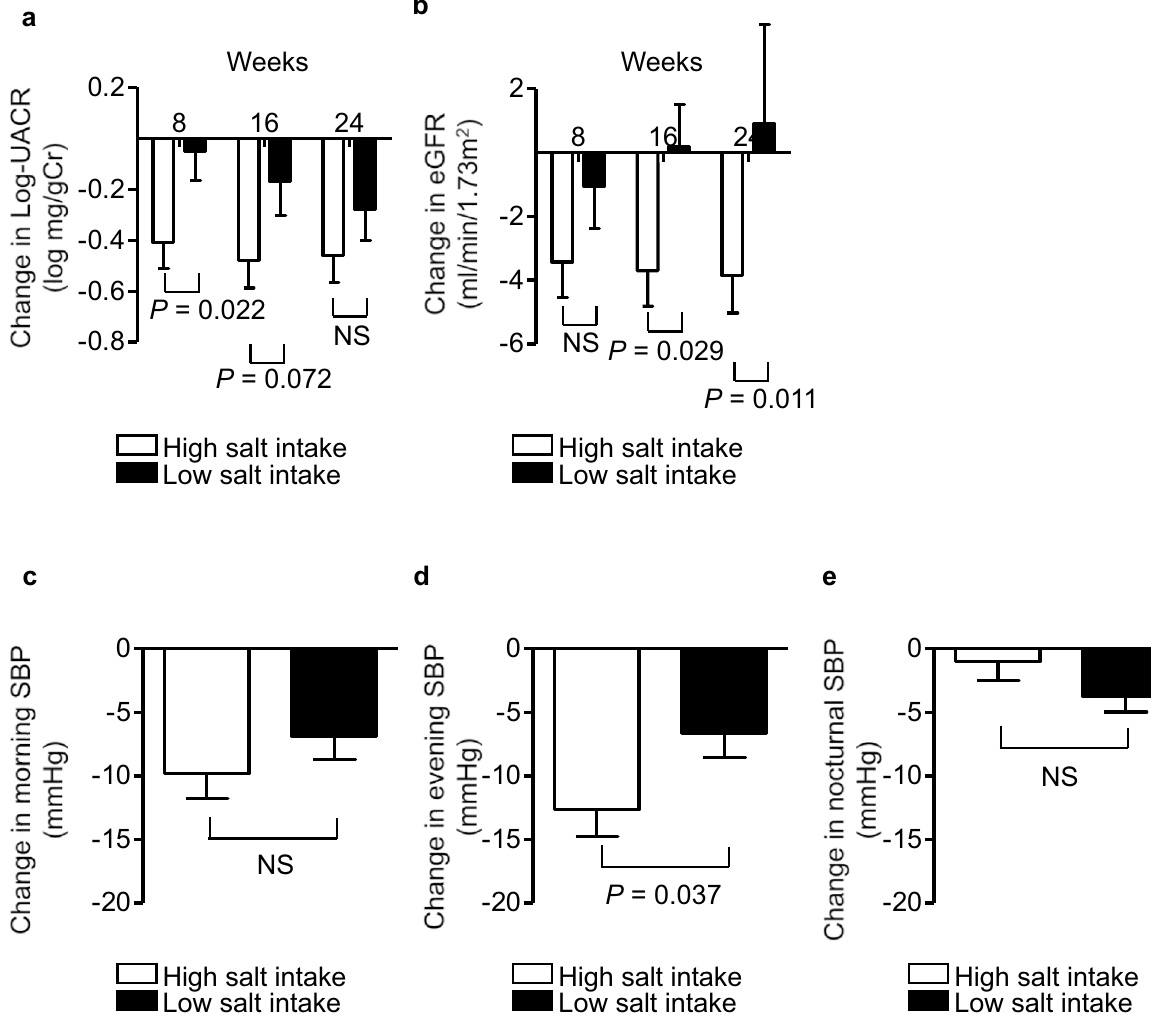
Figure 4. Effects of add-on dapagliflozin therapy on renal endpoints and home-measured blood pressure in the high salt intake and low salt intake groups based on the Tanaka formula. Change in (a) natural logarithm of urine albumin-to-creatinine ratio (ln-UACR), and (b) estimated glomerular filtration (eGFR) during the 24-week study period. Change in home blood pressure (BP) ( (c) morning systolic BP (SBP), (d) evening SBP, and (e) nocturnal SBP) during the 24-week study period. Eighty-four DKD patients were allocated to the high salt intake group (open square) or low salt intake group (filled square), according to median estimated daily salt intake calculated using the Tanaka formula at baseline. Values are presented as mean ± SE. Differences in the effects of dapagliflozin treatment between the two groups were analyzed using unpaired t -tests at each visit. NS not